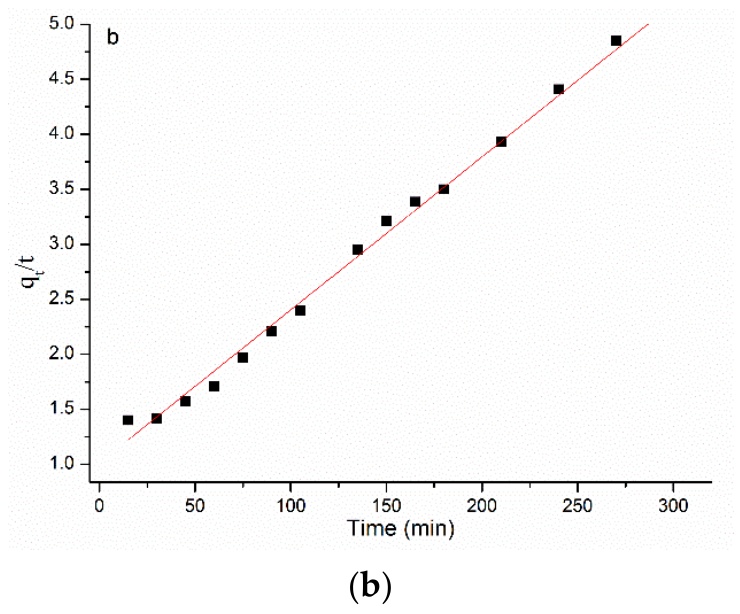
Figure 6. The fitting curve of quasi-first-order kinetic ( a ) and quasi-second-order kinetic ( b ) equation of the adsorption of MO adsorbed by PANI/ZnO.